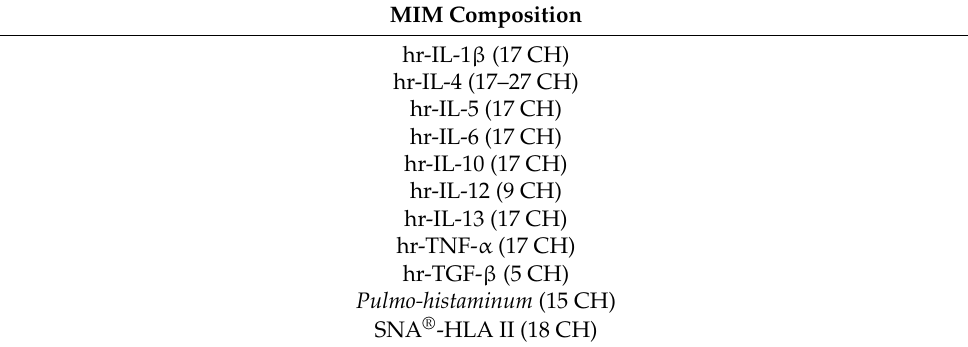
Table 1. Composition of 2LALERG ®